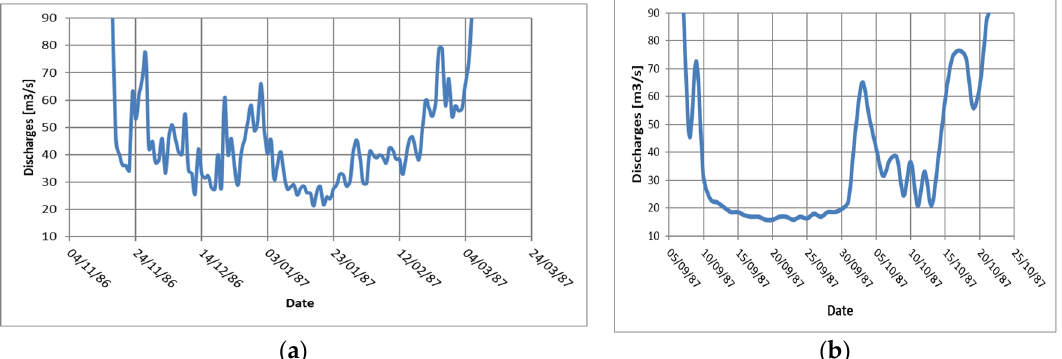
Figure 5. Drought hydrographs: ( a ) maximum deficit volume/duration and ( b ) minimum discharge.